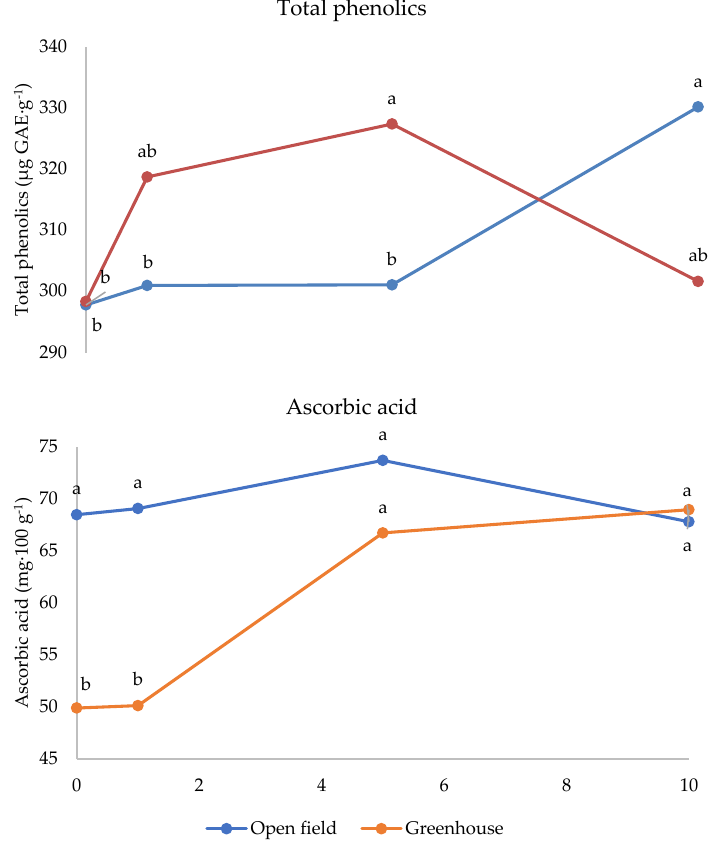
Figure 4. Interaction between Crop system and Melatonin dose on total phenolics and ascorbic acid content of strawberry fruits grown in Isparta region (Turkey), the values followed by different letters are statistically different according to Tukey’s HSD test at p ≤ 0.05.